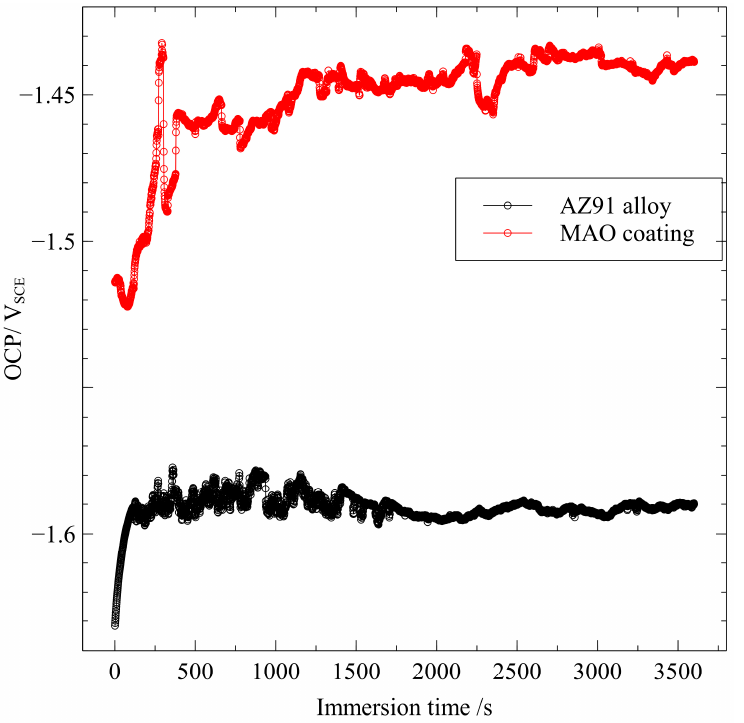
Figure 3. Time-dependent corrosion potential of the AZ91 alloy before and after MAO treatment for 1 h immersion in a 3.5% NaCl solution. 1 h immersion in a 3.5% NaCl